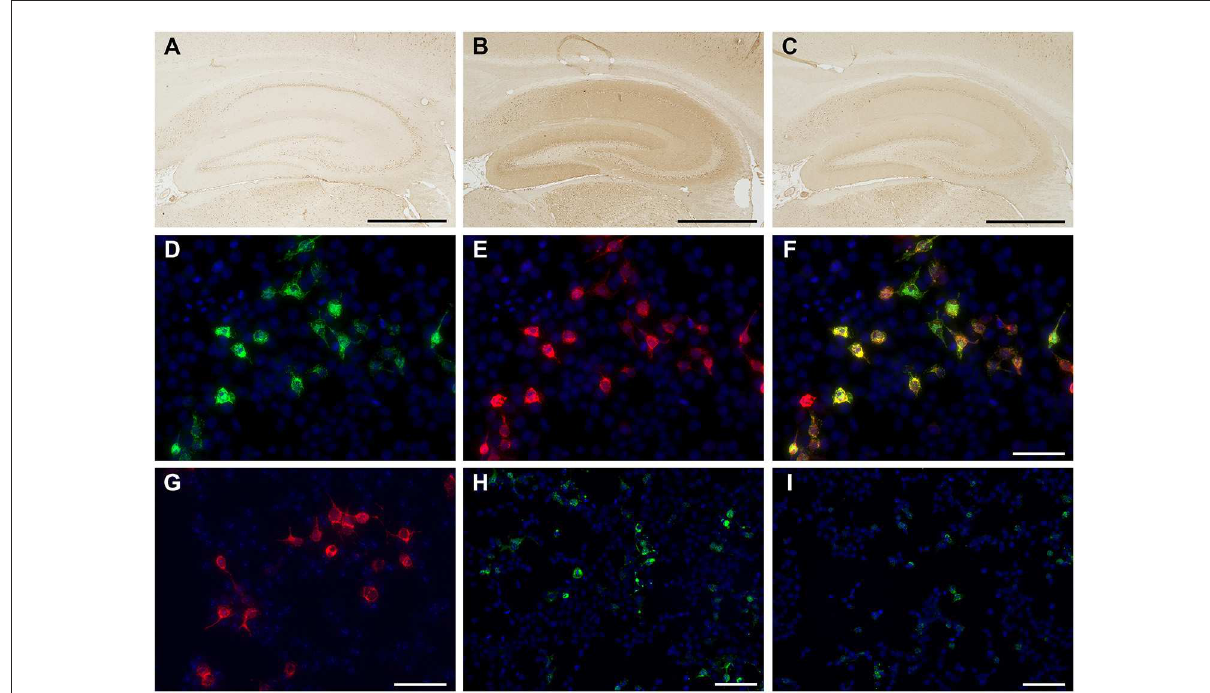
FIGURE2 Immunolabeling of the patient’s cerebrospinal fluid (CSF) sample with in-house tissue-based assay (TBA) (A–C) and cell-based assay (CBA) (D–I) . Control CSF did not react with in-house TBA (A) , whereas the initial patient’s CSF immunolabeled neuropil on the rat hippocampus in the TBA (B) . The patient’s CSF showed reactivity [green, (D) ], with human embryonic kidney (HEK) cells expressing the N -methyl- D -aspartate receptor (NMDAR). The commercial antibody against NMDAR1 (clone EPR2480Y, ab68144, Abcam) [red, (E) ] colocalizes with that of the patient’s CSF [yellow, (F) ], whereas a control CSF is negative (G) . Anti-NMDAR antibody titers (1:32) were confirmed using the fluorescent reactivity of CBA on the initial patient’s CSF (H) . Following tumor removal and whole-brain irradiation therapy, immunosignals in TBA (C) and CBA decreased, as did antibody titers of anti-NMDAR antibody (titers 1:4) (I) . Nuclei were counterstained with 4 ′ , 6-diamino-2-phenylindole. Bars = 1000 µ m (A–C) , 50 µ m (D–G) , and 100 µ m (H, I)